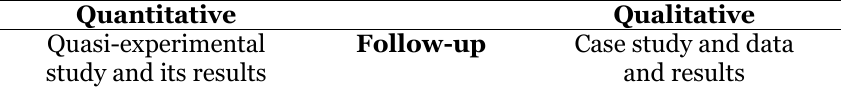
Quantitative Qualitative Quasi-experimental Follow-up Case study and data study and its results and results